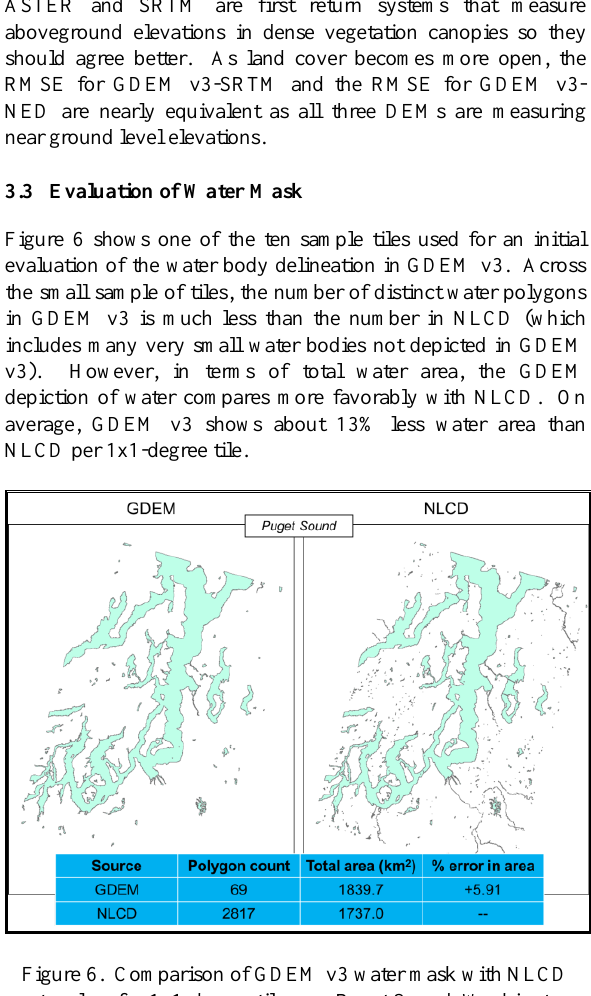
Figure 6. Comparison of GDEM v3 water mask with